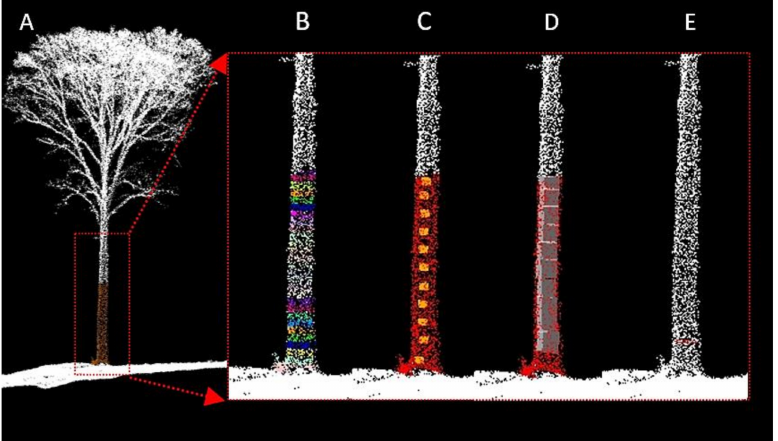
Figure 10. ( A ) Tree cloud delineated from ULS-V-Pcloud with a slice of stem around the DBH; ( B ) clus- tered stem; ( C ) merged clusters into logs; ( D ) cylinder fitted onto the log; and ( E ) DBH